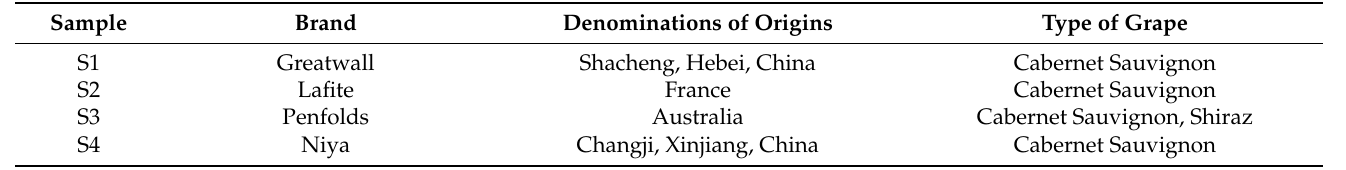
Table 1. Characteristics of wine samples under